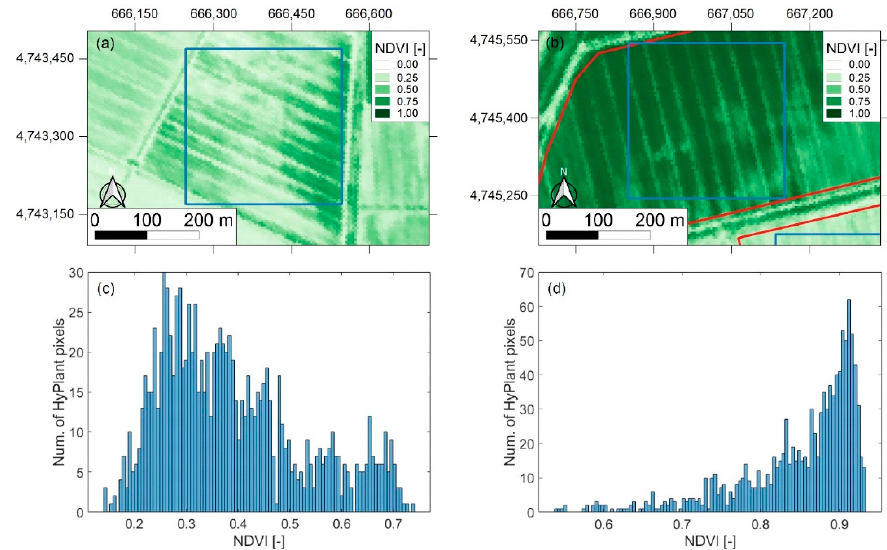
Figure 10. NDVI maps ( a , b ) and frequency distribution histograms ( c , d ) of two FLEX pixels characterised by a single land cover class and a high intra-pixel standard deviation of SIF 760 ( σ ). The map projection is UTM zone 32N with datum WGS84.